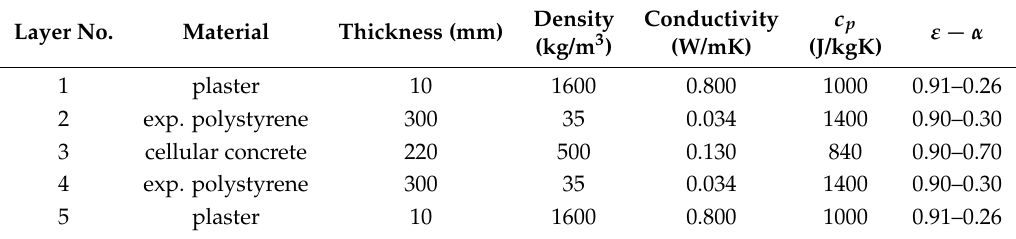
Table A6. Case F: light wall with 5 layers, “PL3” (Layer 1 is outdoors). Thickness: 300 mm. Layer No.